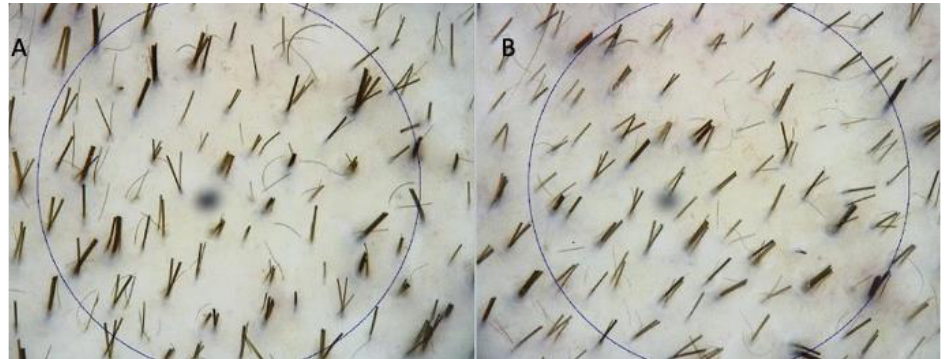
Figure 4. TrichoScan digital image analysis performed by Fotofinder in a patient is shown in Figure 5. ( A ) At T0 pre-operative hair density was 63 ± 2 hairs/cm2 and proportions of telogen and anagen hairs were 36.1% and 55.6%, respectively; ( B ) at T1-16wks post-operative hair density was 80 ± 2 hairs/cm 2 , and proportions of telogen and anagen hairs were 44.7% and 51.3%, respectively.